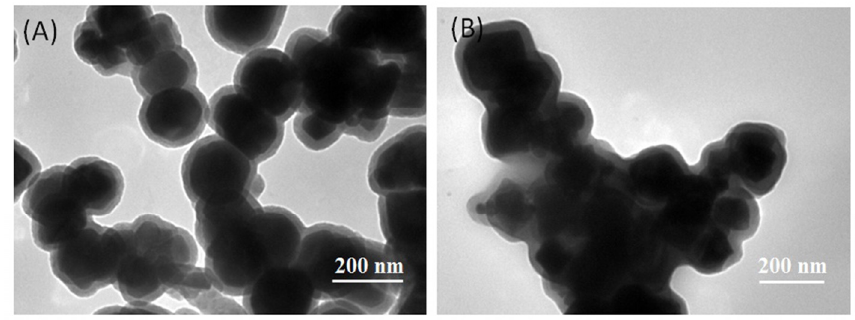
Figure 1. Transmission electron microscopy (TEM) images of polydopamine-coated Fe 3 O 4 nanoparticles ( A ) and the immobilized enzyme ( B ).